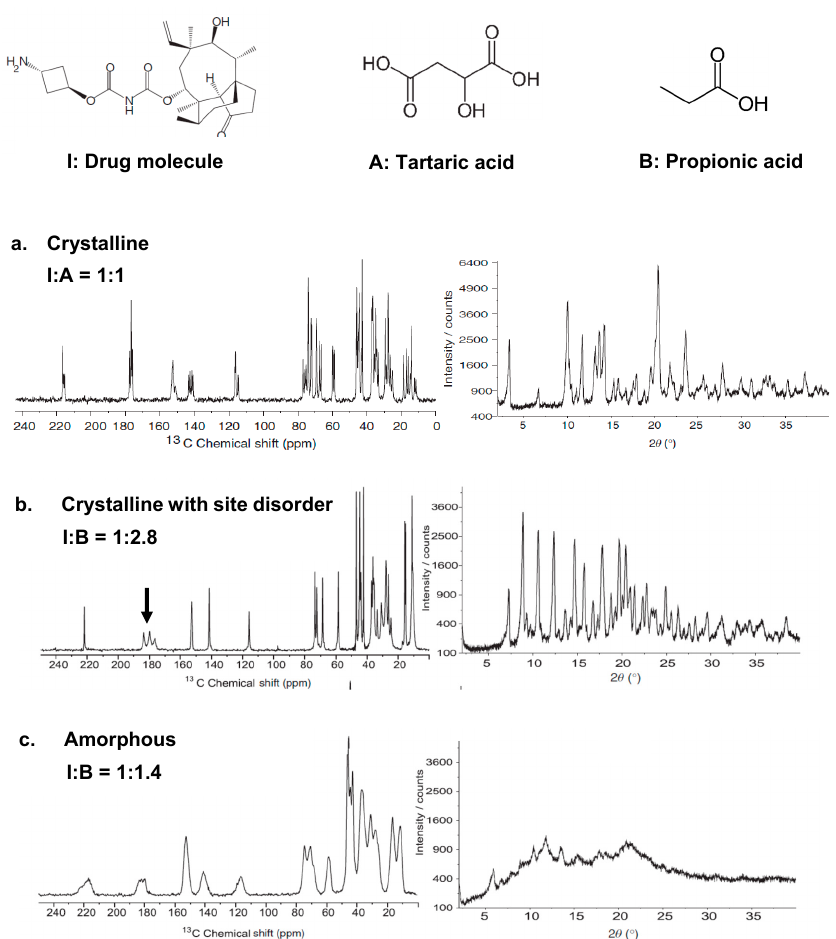
di ff raction peaks in the XRD pattern. In Figure 2b, by crystallizing the mixture of I and base B in a 1: 2.8 ratio, a disorder occurred selectively on a carbonyl site, visualized as broadening e ff ects on the carbonyl peaks at around 180 ppm. The triplet is indicative of a crystalline system with multiple molecules in the asymmetric unit ( Z ’), according to the author. The XRD pattern, however, still shows high crystallinity due to the lack of sensitivity to the local site disorder. When the sample was prepared in a non-crystalline form by mixing I and base B in a specific ratio 1: 1.4, as indicated in Figure 2c, both the NMR and XRD pattern were broadened and lost resolution, due to the loss of long-range order. Note that the inhomogeneous broadening arising from the chemical shift distribution should always be di ff erentiated from the homonuclear broadening [49]. One-dimensional spectroscopy is usually incapable of distinguishing between these two e ff ects, but 2D NMR methods can, by producing di ff erent types of cross peaks in each case, as will be discussed below.